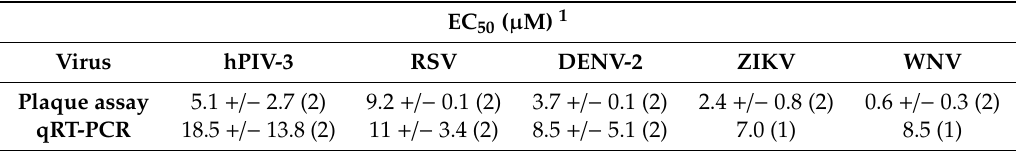
Figure 3. RK-33 is a broad-spectrum inhibitor of infectious virus. Vero cells were infected with ( A ) dengue virus serotype 2 (DENV-2), ( B ) Zika virus (ZIKV), ( C ) West Nile virus (WNV), ( D ) respiratory Table 1. Pooled half maximal e ff ective concentration (EC 50 ) data from replicate plaque assays syncytial virus (RSV) or ( E ) human parainfluenza virus type 3 (hPIV-3) at a multiplicity of infection and RT-qPCRs. (MOI) of 1 for 2 h, after which virus was removed, and fresh medium containing 2% FBS was supplemented with the indicated concentration of RK-33. Released virus samples (for hPIV-3, DENV- EC 50 ( µ M) 1 2, ZIKV and WNV) or cell-associated samples (for RSV) were collected 22 h later, and viral titres Virus hPIV-3 RSV DENV-2 ZIKV WNV (expressed as plaque forming units (pfu) per mL) determined by plaque assay. Dose-response curves were plotted from the viral titres (pfu) versus the logarithmic value of the concentrations of RK-33. Plaque assay 5.1 +/ − 2.7 (2) Results represent the mean +/ − standard deviation (SD) for duplicate wells from a single assay, 1 Results represent the mean +/ − standard deviation (SD) (n) from analysis as per Figures 3 and 4. representative of two (n = 2) independent experiments. See Table 1 for pooled data from the two assays.